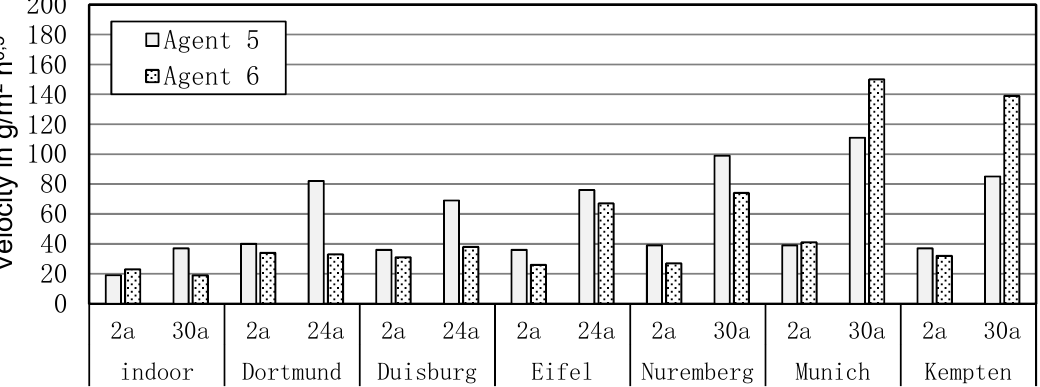
Figure 9. Velocity of water uptake between 5 and 120 minutes for OKS samples treated with agents 5 and 6 and weathered at the 7 different locations.